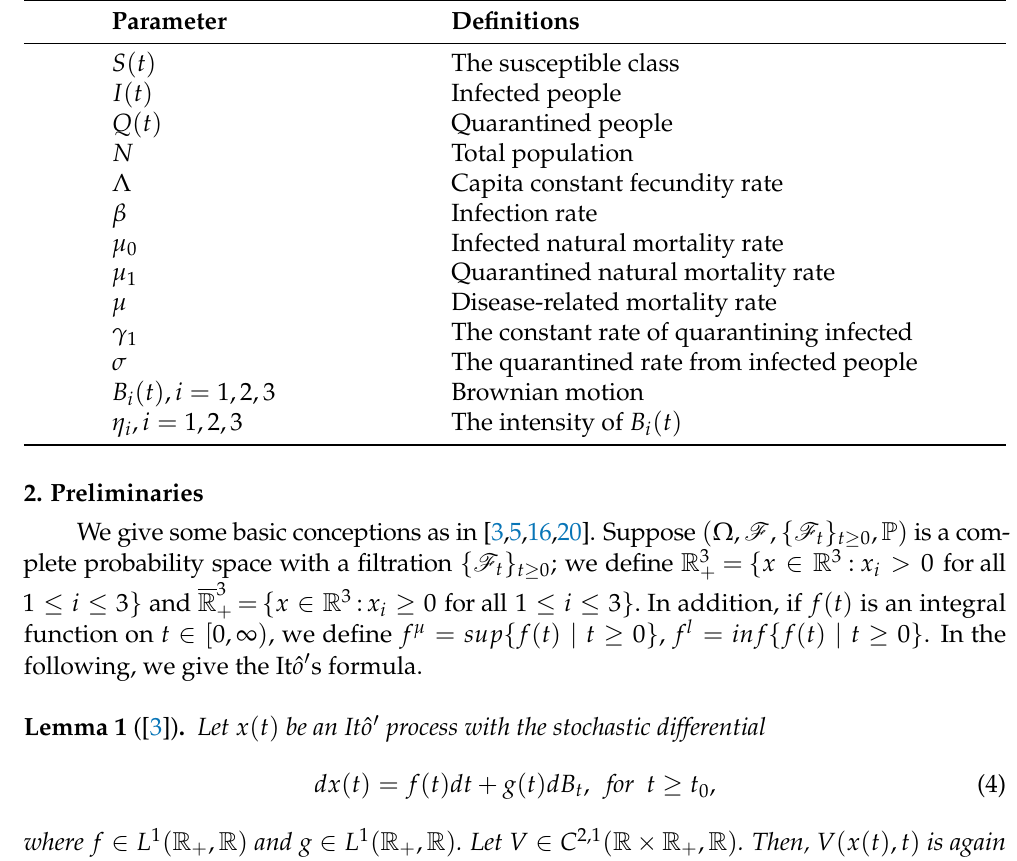
Table 2. The definitions of the